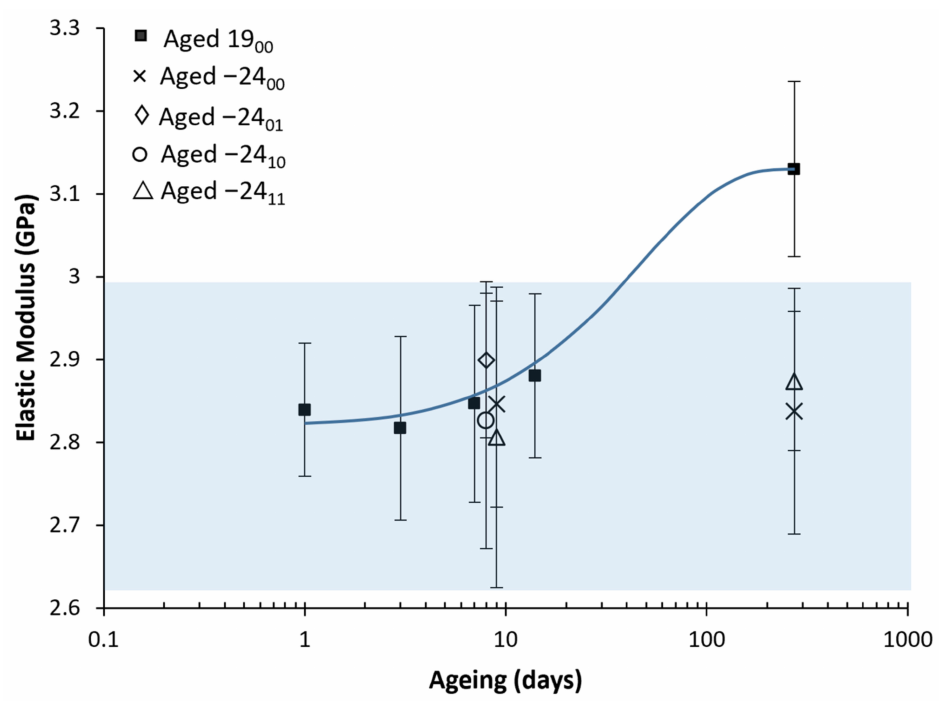
Figure 10. The average value of the elastic modulus with its mean square error vs ageing. The reference material aged at room temperature has bold marks and its logistic fitting (line). For better visualisation, samples aged to nine days are separated into 8 and 9 days in the graph, but all correspond with nine days. The shadow area shows the frozen sample value interval. Six samples were measured for each ageing conditions and error bars are the standard deviation.